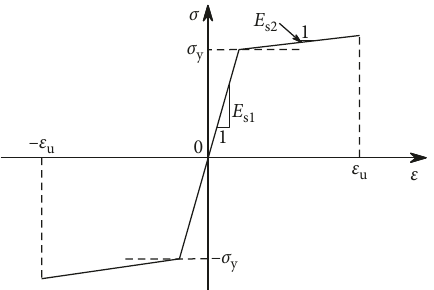
Figure 7: Constitutive relationship of